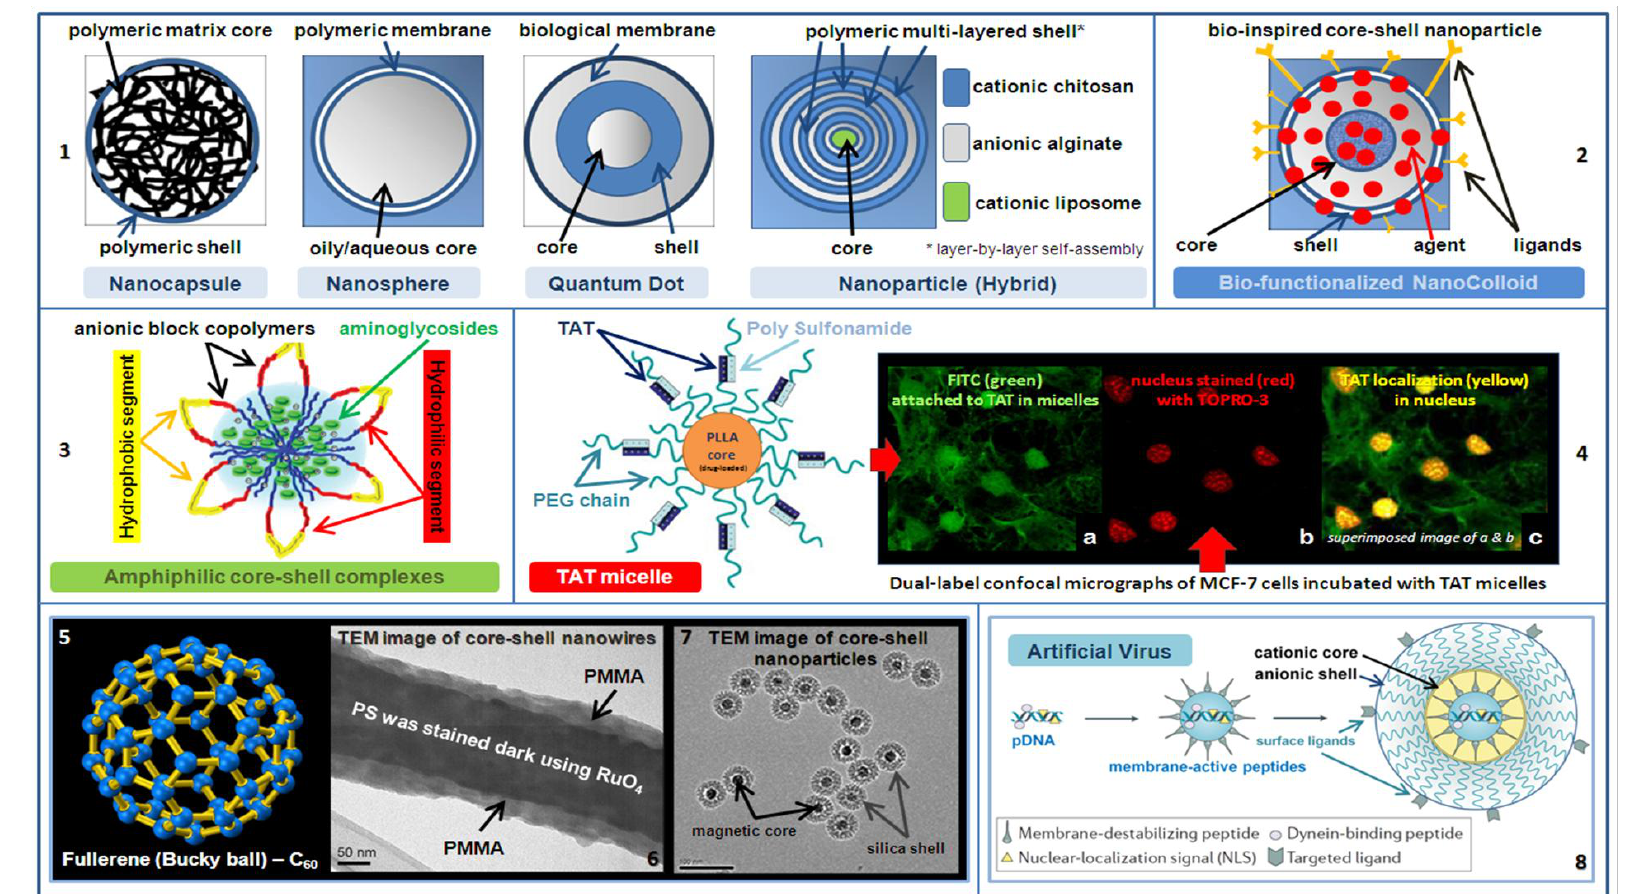
Top row (1 and 2): Spherical nanoparticles with a schematic representation of a layer-by-layer (L-b-L) self-assembled multi-layered nanoparticulate delivery system and a bio-functionalized colloid for targeted drug, protein and gene delivery. Middle row (3 and 4): An amphiphilic polymer